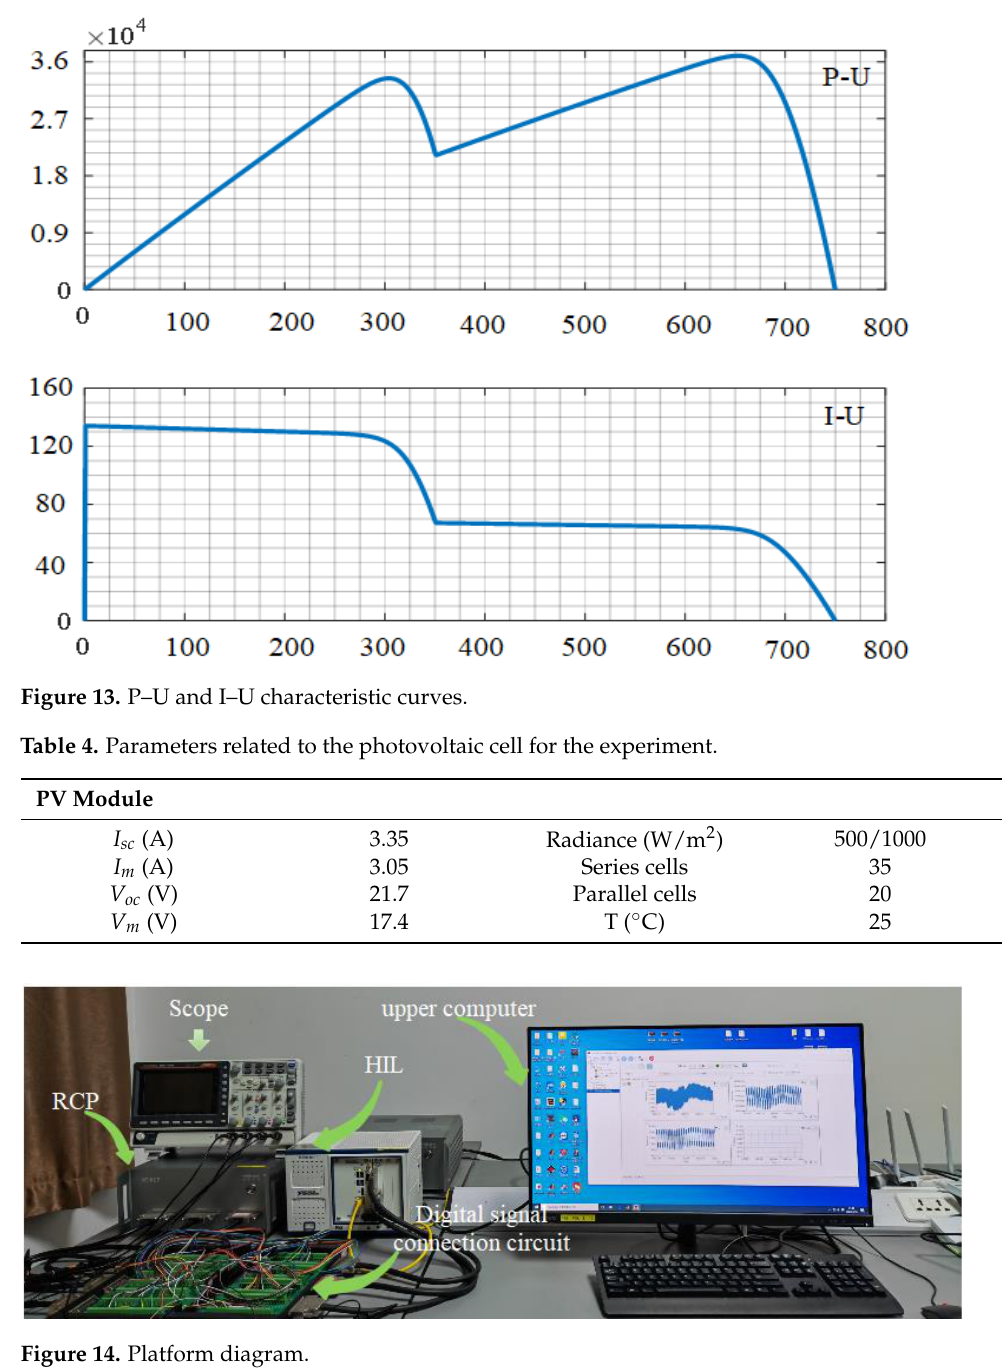
Figure 14. Platform diagram.